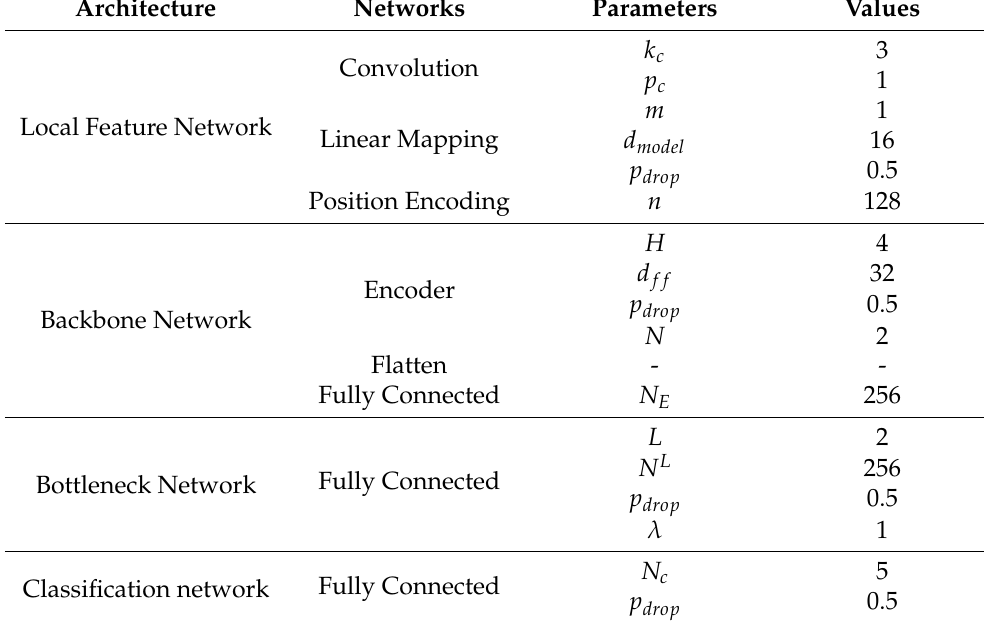
Table 3. Parameters of Encoder-JMMD.